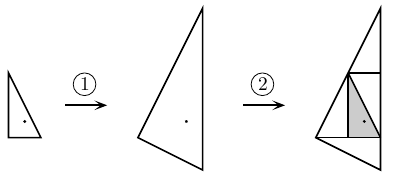
Figure 3. Inflation rule of the pinwheel tiling, consisting of a √ rescaling by a linear factor of 5 (step 1) followed by a dissec- tion into five triangles of the original size (step 2). The rotation ensures that the shaded triangle has the same orientation as the original one, which ensures that iterating the rule can be used to define an infinite tiling; see [3] for details √ The tile is a right triangle of side lengths 1, 2 and 5.